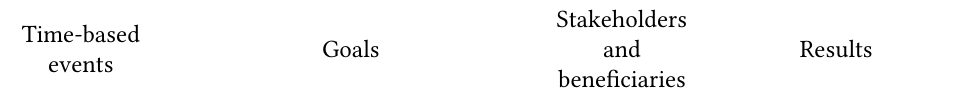
Hackathon’s classification